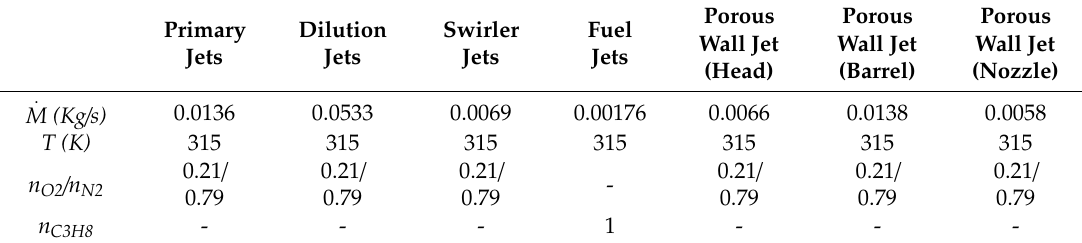
Table 2. Numerical boundary